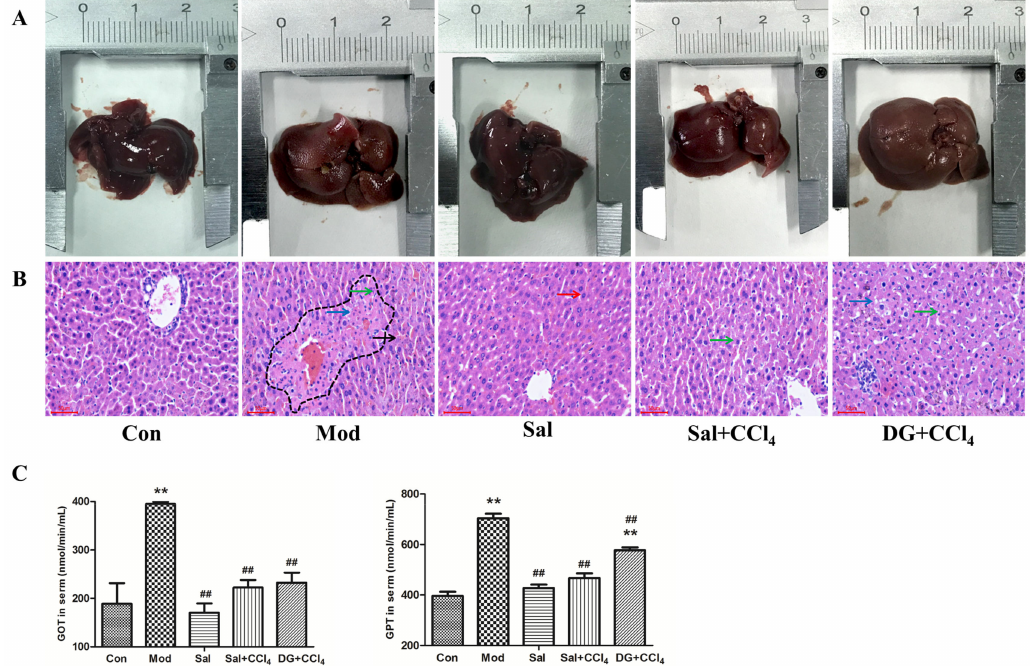
Figure 2. Salidroside attenuated carbon tetrachloride (CCl 4 )-induced liver steatosis and decreased hepatic transaminases in mice ( n = 6). ( A ) Macroscopic characteristic of livers in control mice, model mice induced by CCl 4 , and mice treated with single salidroside, salidroside + CCl 4 , and diammonium glycyrrhizinate + CCl 4 (Con, Mod, Sal, Sal + CCl 4 , and DG + CCl 4 , respectively). Livers in the Con and Sal groups had normal gross morphology. However, the livers of mice in Mod, Sal + CCl 4 , and DG + CCl 4 groups showed increased volumes, decreased glossiness, and smoothness. The most severe and slightest lesions were observed in the Mod and the Sal + CCl 4 groups, respectively. ( B ) Pathologic histology of livers in di ff erent groups. Mild steatosis can be observed in the liver of the Con group, and the Sal group showed a normal structure. Histopathological changes showed the fatty degeneration and necrosis of hepatocytes and infiltration of inflammatory cells, which were more and increasingly mild in the Mod, Sal + CCl 4 , and DG + CCl 4 groups. Red arrows marked normal hepatocytes, green arrows marked cell nucleus pyknosis, black arrows marked cell nucleus broken, blue arrows marked vacuoles caused by steatosis, and dotted line denoted necrotic area. Magnification: 200 × . ( C ) GOT and GPT activities in the serum of di ff erent groups. CCl 4 treatment increased the serum GOT and GPT levels ( p < 0.05). Salidroside reduced the CCl 4 -induced transaminase, and DG only alleviated GOT condition significantly ( p < 0.05). The single-treatment of salidroside had no side-e ff ect. p < 0.05 was considered statistically significant. ** p < 0.05 (groups compared with the Con group) and ## p < 0.05 (groups compared with the Mod group). (GOT: glutamic oxalacetic transaminase; GPT: glutamic-pyruvic